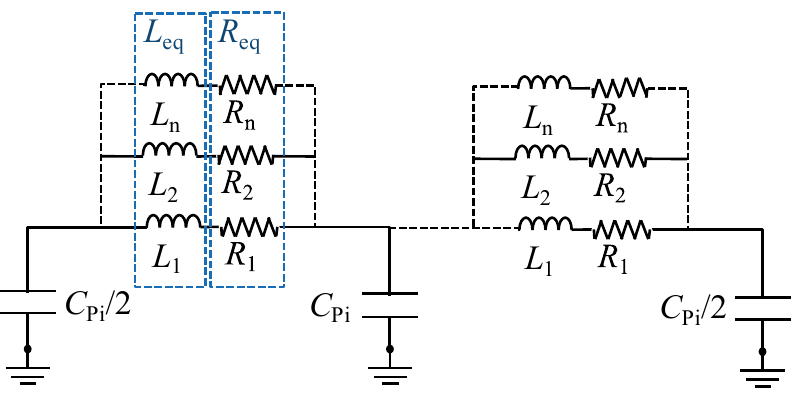
Figure 4. FD-Pi sections.